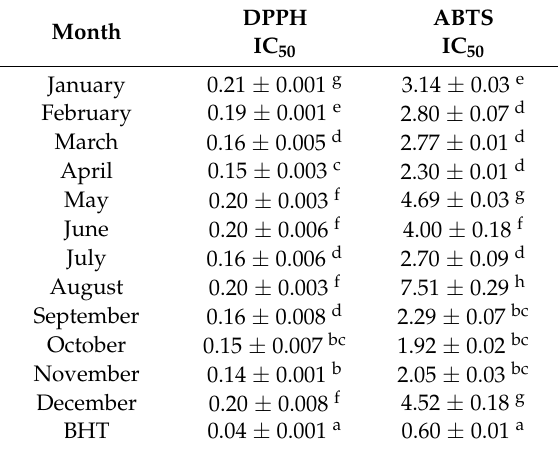
Table 4. DPPH, ABTS assays results (in mg/mL) of Hawk tea from 12 months.